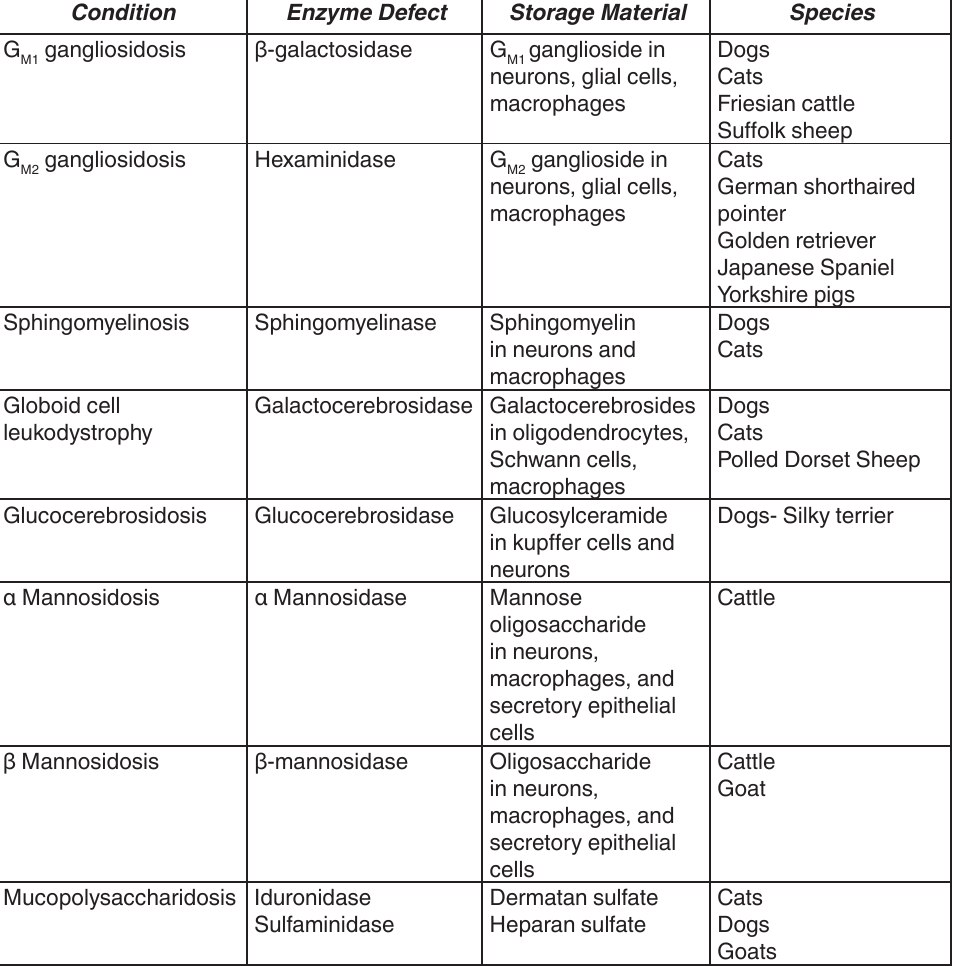
table1 : Selected inherited lysosomal storage disease